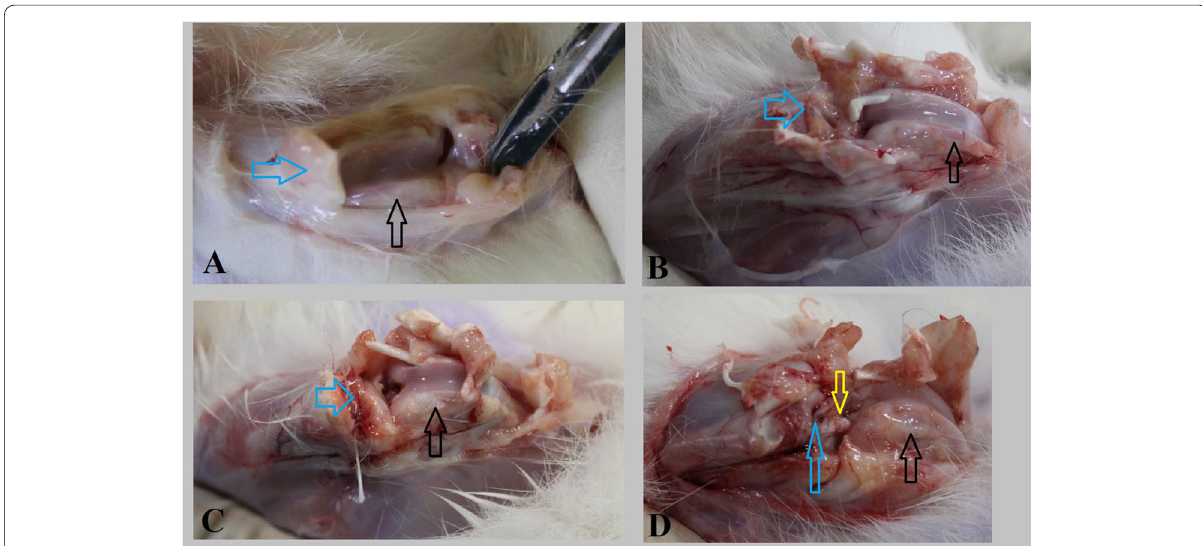
Fig. 1 A Stage Zero of adhesion band formation with visual score system assessment, note that there is no adhesion band seen, Also no synovium proliferation is observed. B Stage one of adhesion band formation with visual score system assessment, note that there is minimal adhesion band formed. C Stage two of adhesion band formation with visual score system assessment, note that there is moderate adhesion band formation needs manual traction for releasing. D Stage three of adhesion band formation with visual score system assessment, note that joint is completely stiff and needs surgical release, while also synovium proliferation is observed; (Black arrow indicator of the femoral articular surface; Blue arrow indicator of the tibial articular surface; Yellow arrow indicator of dense adhesion band)